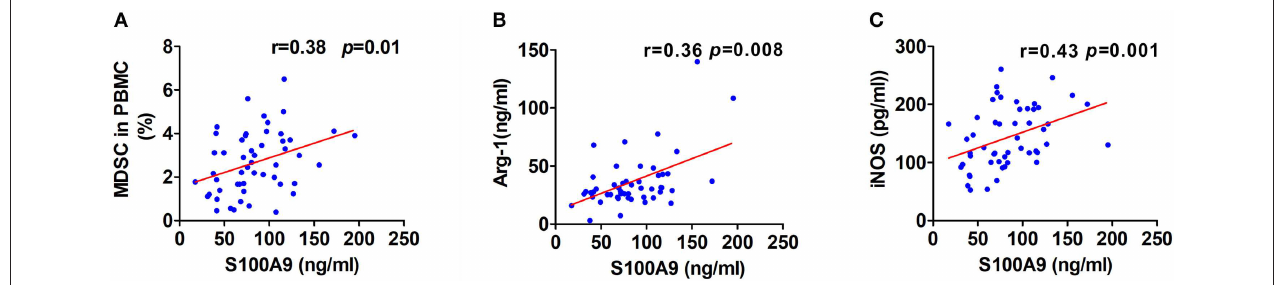
FIGURE 4 | The influence of S100A9 in LoVo-induced MDSCs vitality, chemotaxis and activation in vitro. (A) The CD33 + cells were separated from PBMCs with CD33 positive magnetic beads, and co-cultured with LoVo cells to induce into CRC-associated MDSCs in vitro . (B) Identification of LoVo induced-MDSCs characterized by the myeloid marker with HLA-DR − CD33 + CD11b + by FCM. CD33 + cells cultured in medium alone were included as a control. (C) CCK8 assay for cell viability of LoVo-induced MDSCs treated with different concentrations of GST-S100A9 (5, 10, and 20 µ g/ml) and GST proteins for 12, 24, and 48h. (D) Chemotaxis assay for LoVo-induced MDSCs treated with different concentrations of GST-S100A9 (5, 10, and 20 µ g/ml) and GST proteins for 24h. (E–G) Real-time PCR analysis for mRNA expression of immunosuppressive molecules, including Arg - 1 (E) , iNOS (F) , and IL - 10 (G) in LoVo-induced MDSCs after GST-S100A9 (20 µ g/ml) and GST (20 µ g/ml) protein treatment for 24h. (H) Fluorescence intensity analysis for ROS production in LoVo-induced MDSCs treated with GST-S100A9 (20 µ g/ml) and GST (20 µ g/ml) proteins. (I) Suppression of LoVo-induced MDSCs treated with GST-S100A9 (20 µ g/ml) and GST (20 µ g/ml) proteins on T cells in vitro. (J) A statistical graph of the suppressive effect of LoVo-induced MDSCs treated with GST-S100A9 (20 µ g/ml) and GST (20 µ g/ml) proteins on CD8 + T cells. Data represent three independent experiments and are represented as Mean ± SD. * p < 0.05, ** p < 0.01, *** p < 0.001.